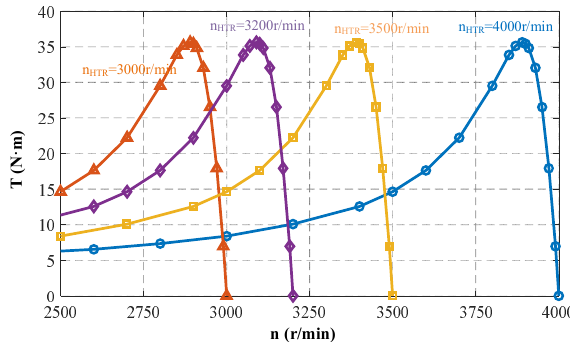
Figure 18. The mechanical properties of the HTR-ASD.